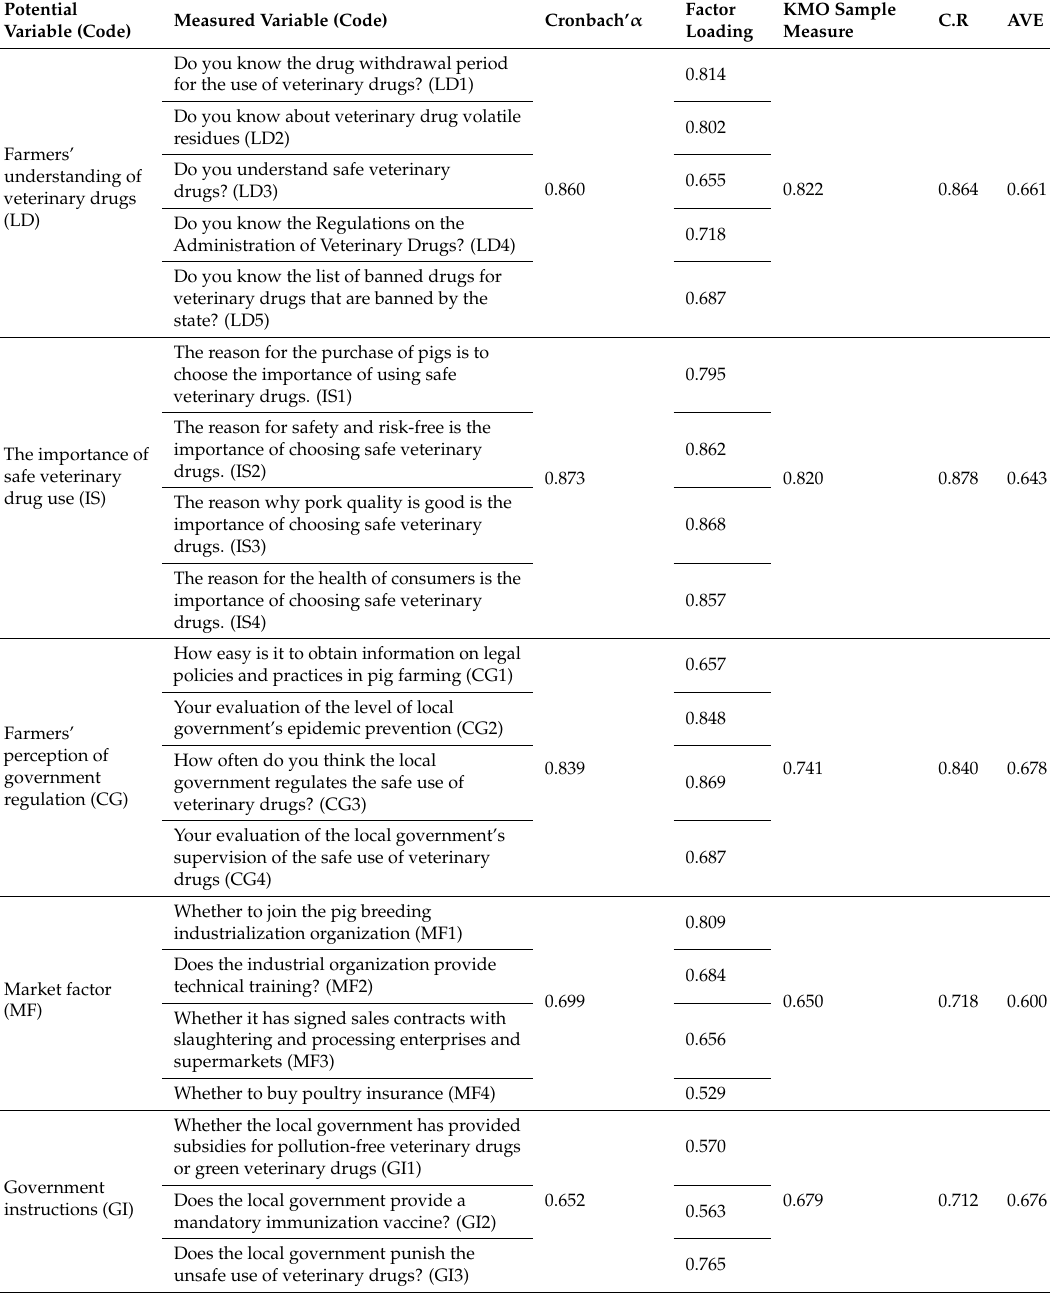
Table 4. Variable exploratory factor analysis, reliability and validity test